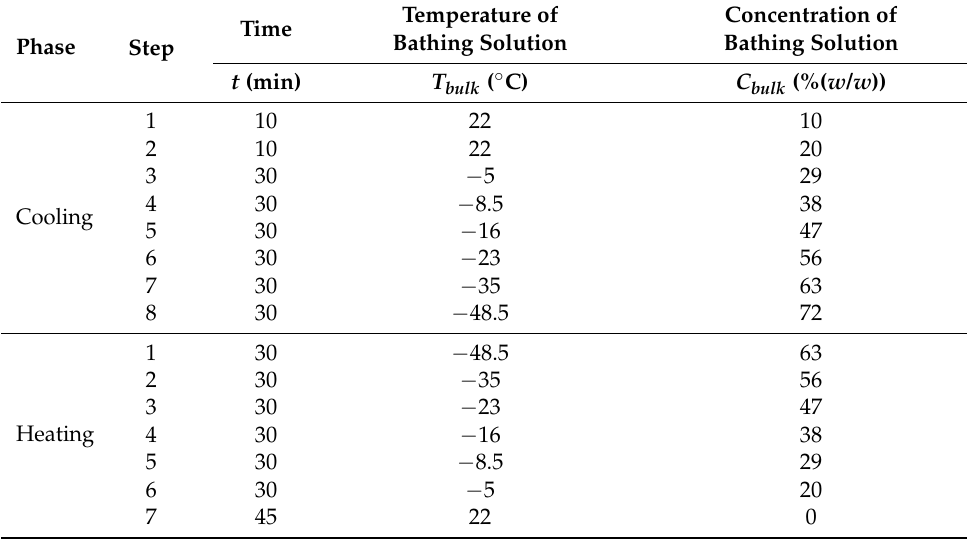
Table 2. The assumption of the LT protocol